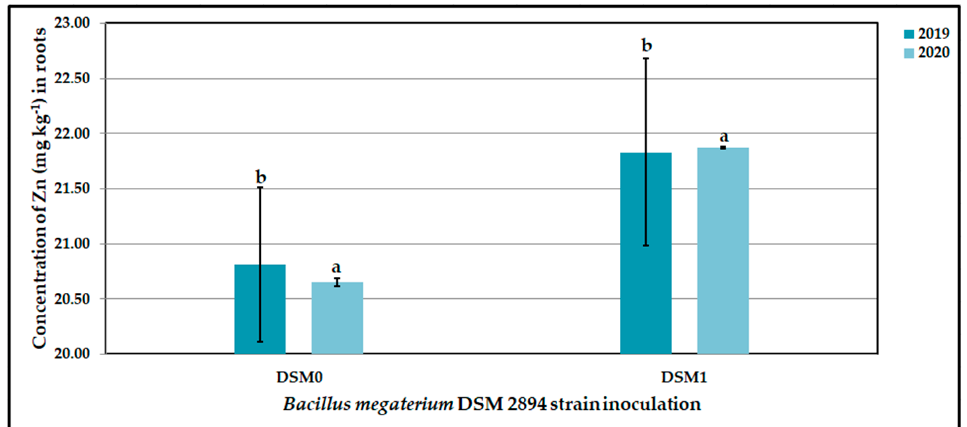
Figure 15. Influence of Bacillus megaterium DSM 2894 var. on root zinc (Zn, mg kg − 1 ) contents of CaCO 3 -stressed sweet potato plants in 2019 and 2020 seasons. Bars with a different letter indicate significant difference between treatments at p ≤ 0.05. DSM 0 = non-inoculated with Bacillus megaterium DSM 2894 var., DSM 1 = inoculated with Bacillus megaterium DSM 2894 var.